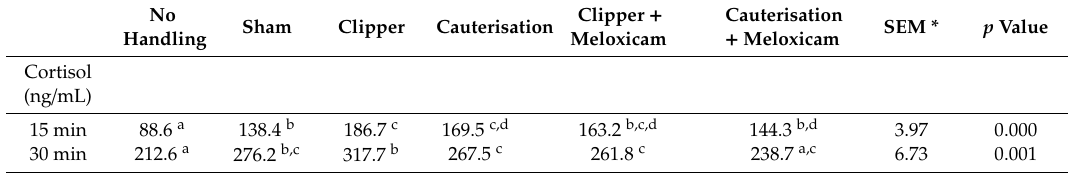
Clipper + Cauterisation + Meloxicam SEM * p Value Meloxicam